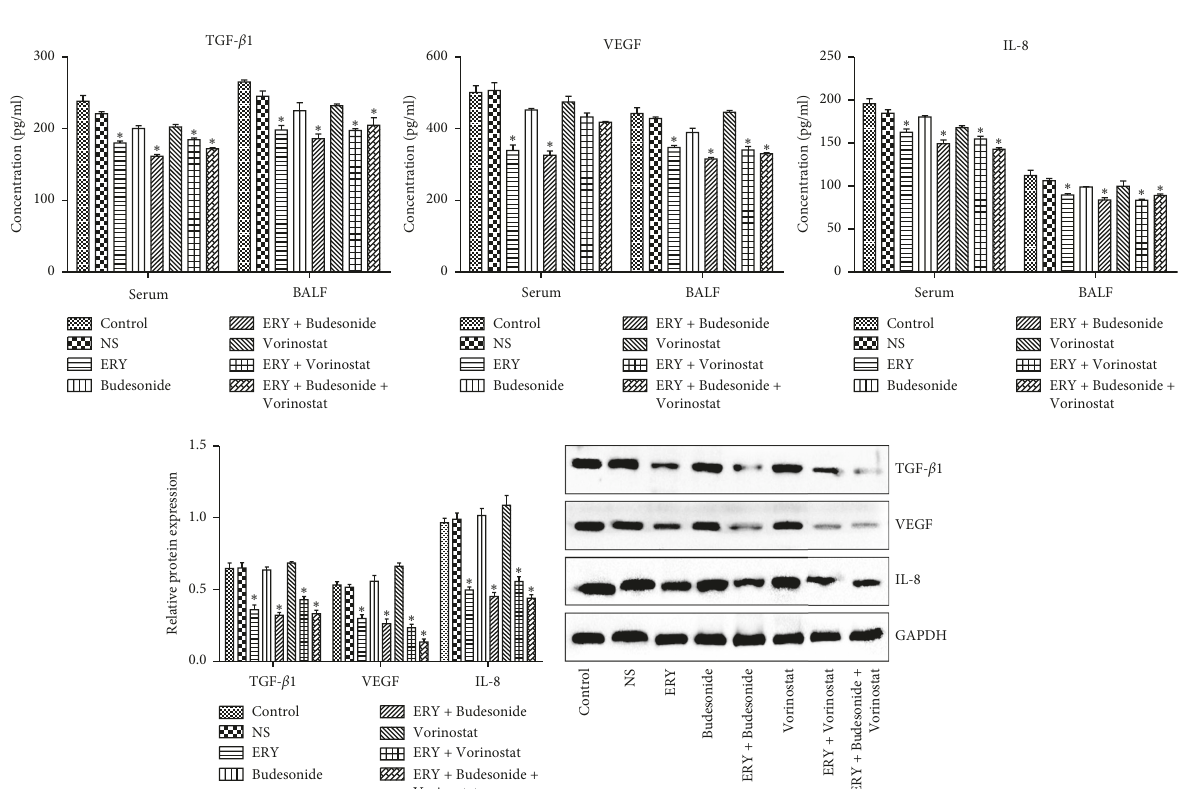
Figure 5: The expression of TGF- β 1, VEGF and IL-8 in different groups. Control: rabbit tracheal stenosis model without treatment; NS: rabbit tracheal stenosis model treated with penicillin; ERY: rabbit tracheal stenosis model treated with erythromycin; Budesonide: rabbit tracheal stenosis model treated with budesonide; Vorinostat: rabbit tracheal stenosis model treated with vorinostat. ∗ P < 0 . 05 vs. Control group.